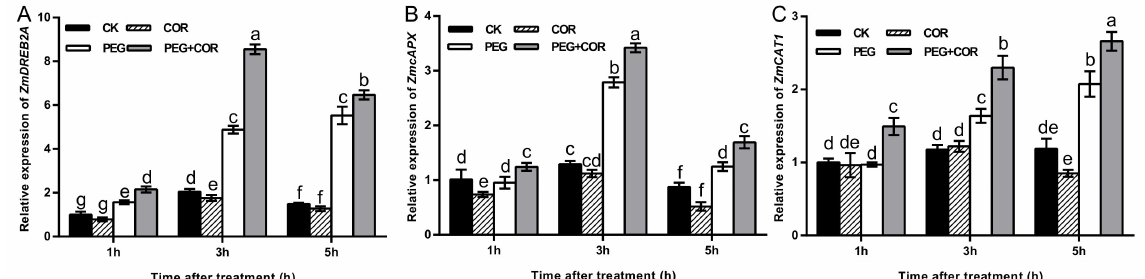
Figure 4. Expression analysis of ZmDREB2A ( A ), ZmcAPX ( B ), and ZmCAT1 ( C ) in leaves of COR-treated and control plants under well-watered conditions and PEG treatment. The gene expression levels of COR-treated and control plants are shown relative to the expression of control plants grown under well-watered conditions at the corresponding time. CK and COR indicated the well-watered plants and well-watered plants treated with COR, respectively. PEG and PEG+COR indicate the water-stressed plants and water-stressed plants in presence of COR, respectively. One hour CK-treatment as calibrator samples. Values are the mean ± SD ( n = 3), and different letters indicate significant differences ( p < 0.05) among the treatments.